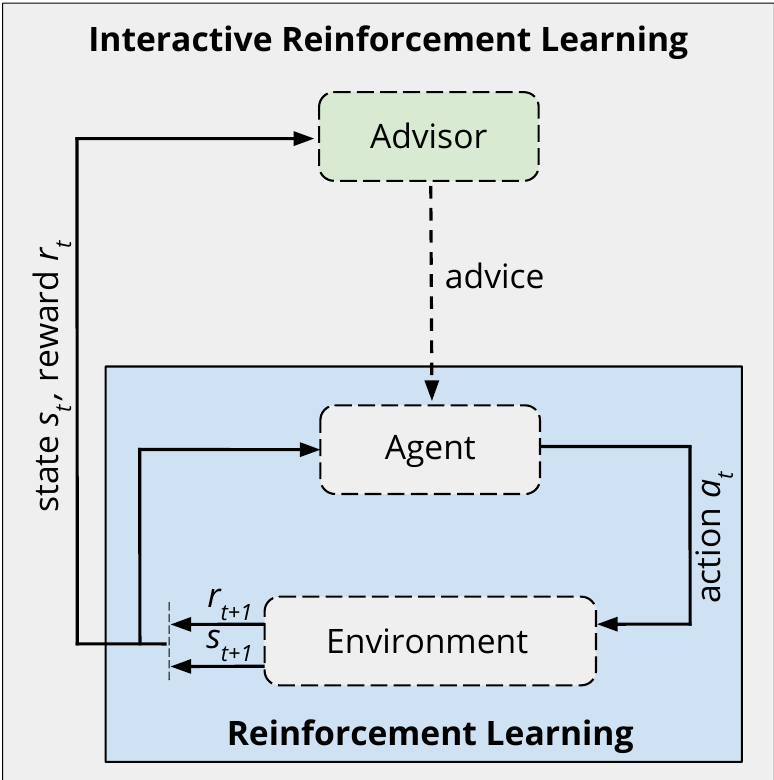
Figure 1. Interactive reinforcement learning approach. An illustration showing the involvement of an advisor and its relation to the traditional reinforcement learning